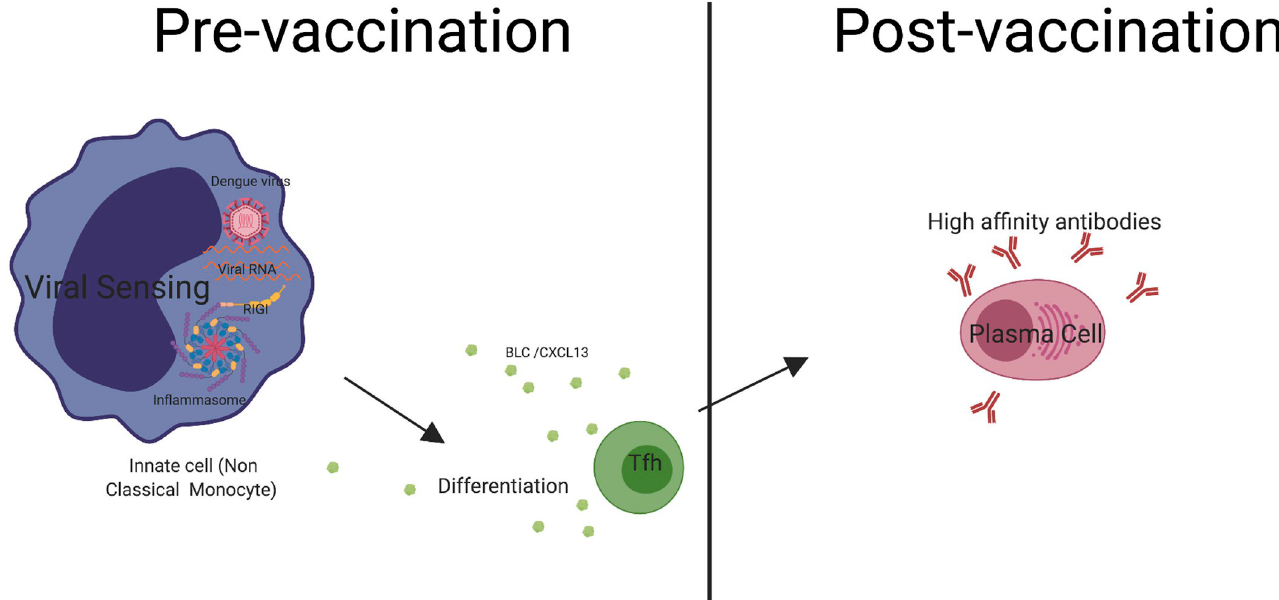
Fig 7. Proposed model. Innate cells such as monocytes are the primary targets of the dengue virus. Prior to vaccination (Pre-vaccination), innate cells sense the virus leading to micro-environmental changes that help the differentiation of Tfh cells. Tfh cells in turn, secrete analytes such as BLC/CXCL13. The changes in the pre-vaccination microenvironment favor the production of high affinity antibodies and antibodies that have virus neutralization functionality post- vaccination.